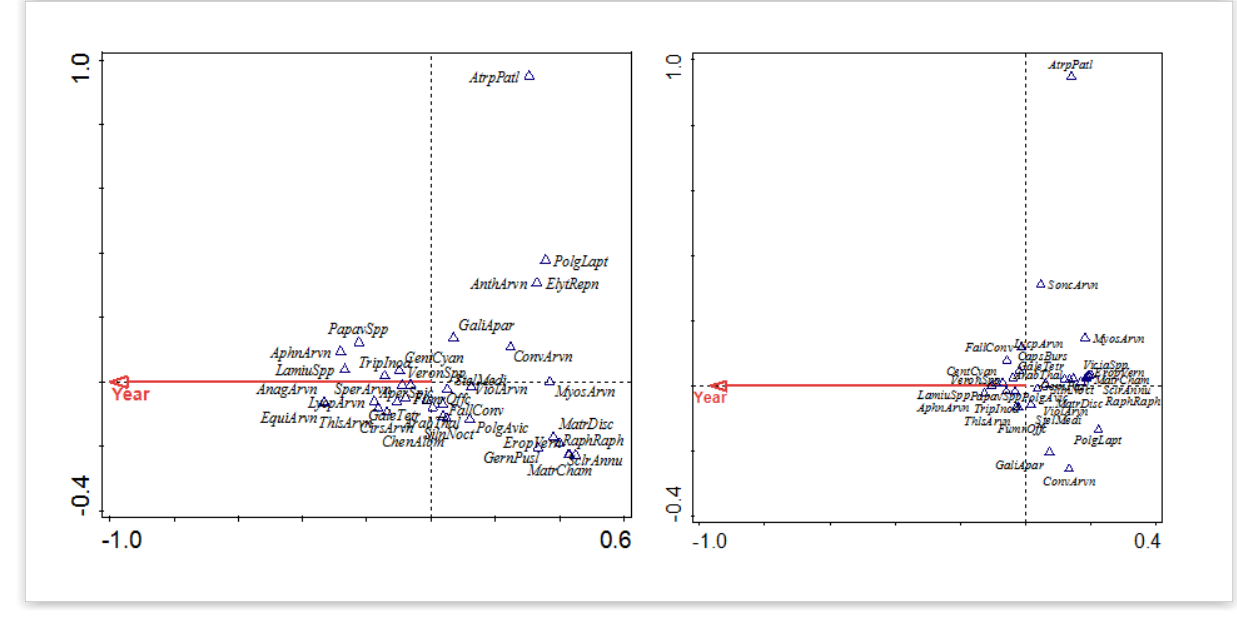
Figure 2. Temporal trends in species composition in Pernolec in simple crop rotation. Ordination diagrams of partial Canonical Correspondence Analysis (CCA) with untreated plots ( right ) and targeted treatment with herbicide combinations ( left ). Year is the explanatory variable and crop type is the covariate; species with low weight are not shown.